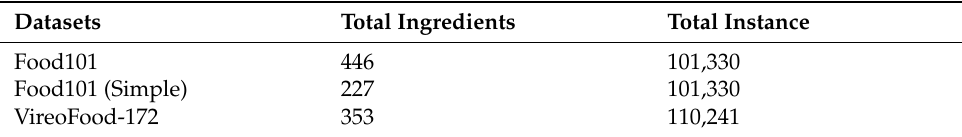
Table 3. Attributes of food datasets for ingredient